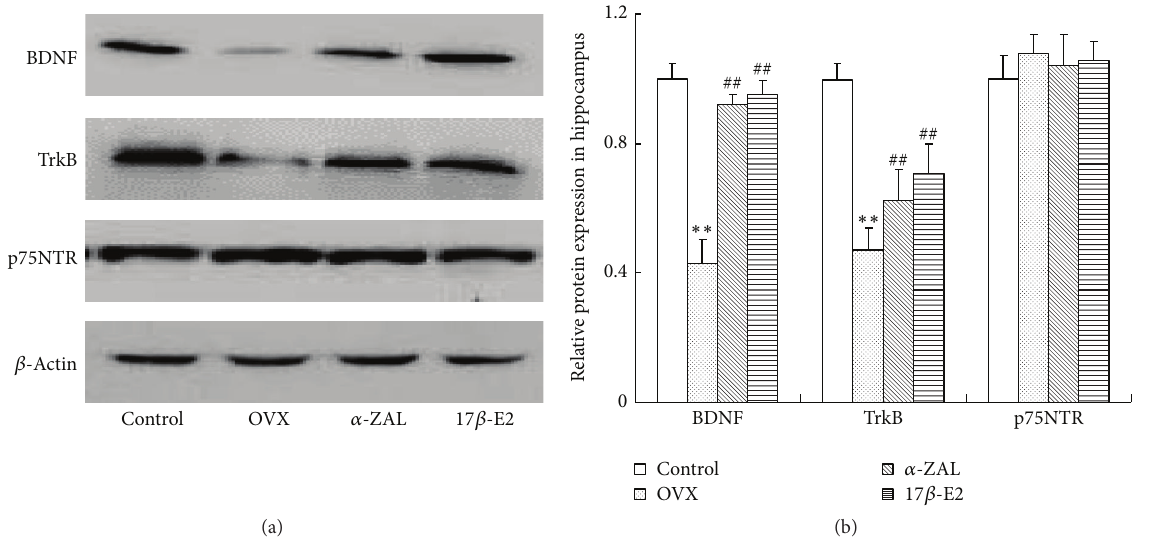
Figure 3: (a) Western blotting analysis the expression of BDNF, TrkB, and p75NTR in hippocampus. (b) Quantitative analysis of protein levels by densitometry. The data from western blot were normalized by taking the value of control group as 1. ∗∗ 𝑃 < 0.01 versus control group; ## 𝑃 < 0.01 versus OVX